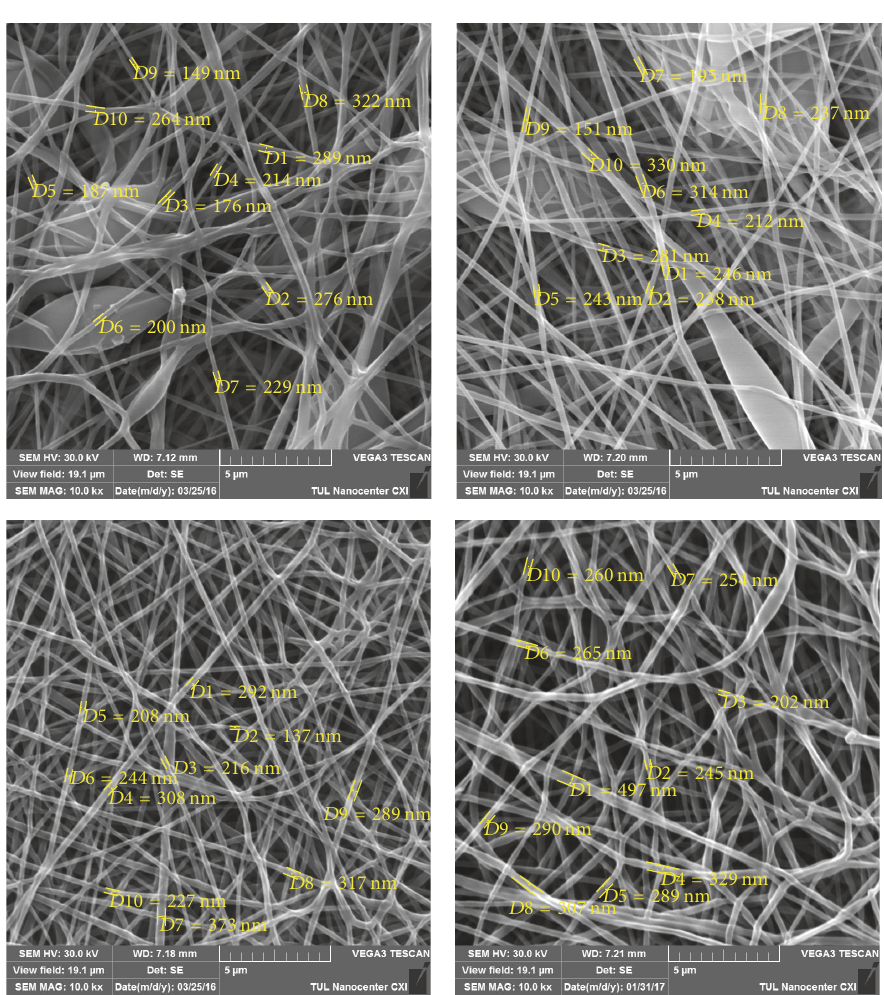
Figure 1: Perpendicular SEM micrographs of membrane structure (10.000x): PUR40, PUR25, PUR10, and